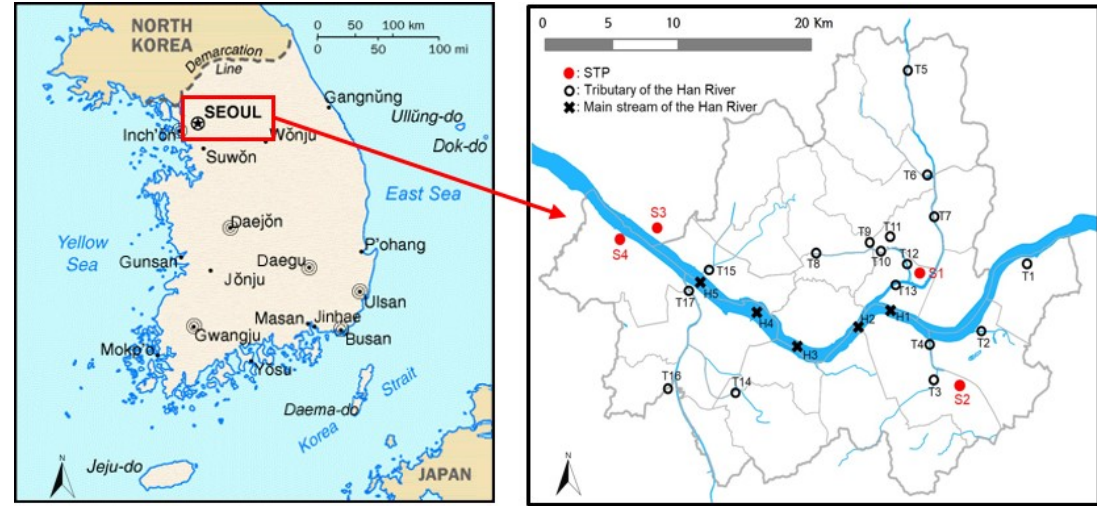
Figure 1. Location of sewage treatment plants and sampling points in the Han River and its tributaries (STP: sewage treatment plant).